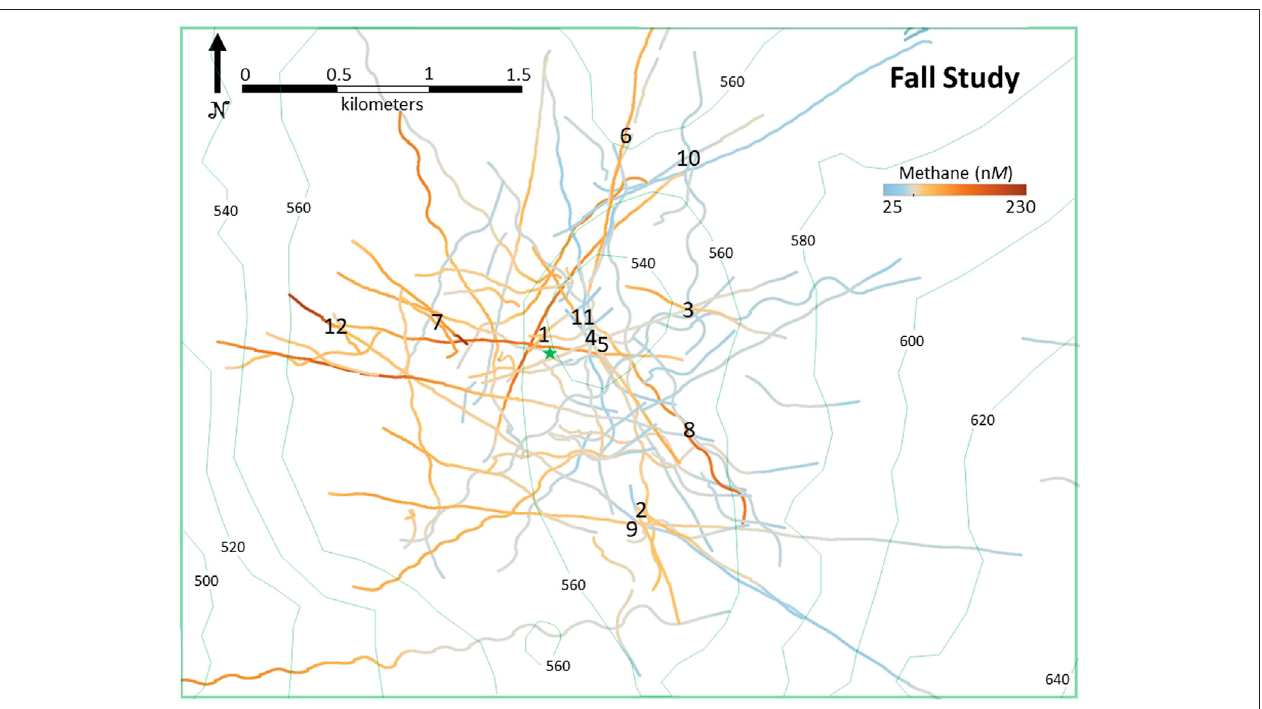
FIGURE 8 | Glider traverse maps for data collected in the fall study of the Bush Hill area (green star marksseep) color coded for methane concentration. The glider paths areoverlainonthesea fl oorbathymetrycontoured inmetersbelowsealevel(bathymetryfromNOAA).Thedivergenceinthemethanecolorcodingcorrespondsto the quantitation limit with orange colors indicating con fi dent methane detection. The numbers correspond to a temporal analysis (see Table 1 ).